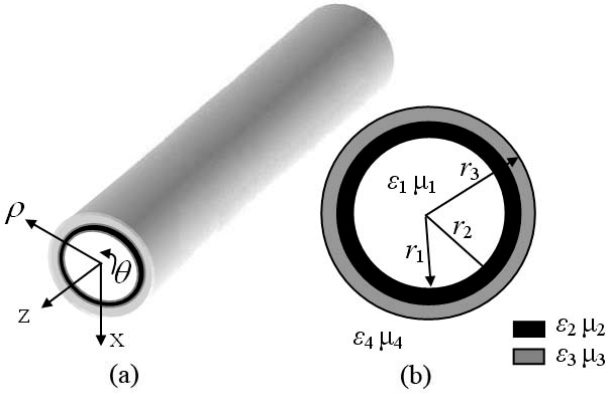
Figure 1. (a) Model of the four-layer cylindrical dielectric waveguide; (b) cross section of the